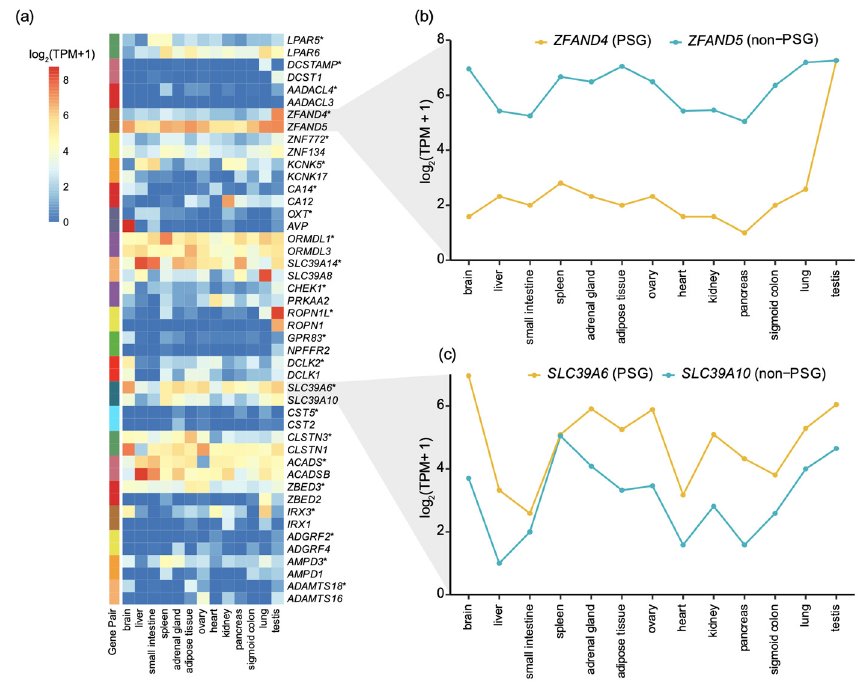
Figure 4. ( a ) Comparison of gene expression levels between PSGs and their closest paralogous non- PSGs. Twenty-three of thirty-nine PSGs in humans had the closest paralogous non-PSGs. The row annotation depicts the gene pair of PSG and its closest non-PSG. Asterisks (*) denote PSGs, and other genes are non-PSGs. Each PSG is next to its corresponding non-PSG. ( b ) Patterns of ZFAND4 and ZFAND5 expression in human tissues. ( c ) Patterns of SLC39A6 and SLC39A10 expression in human tissues.